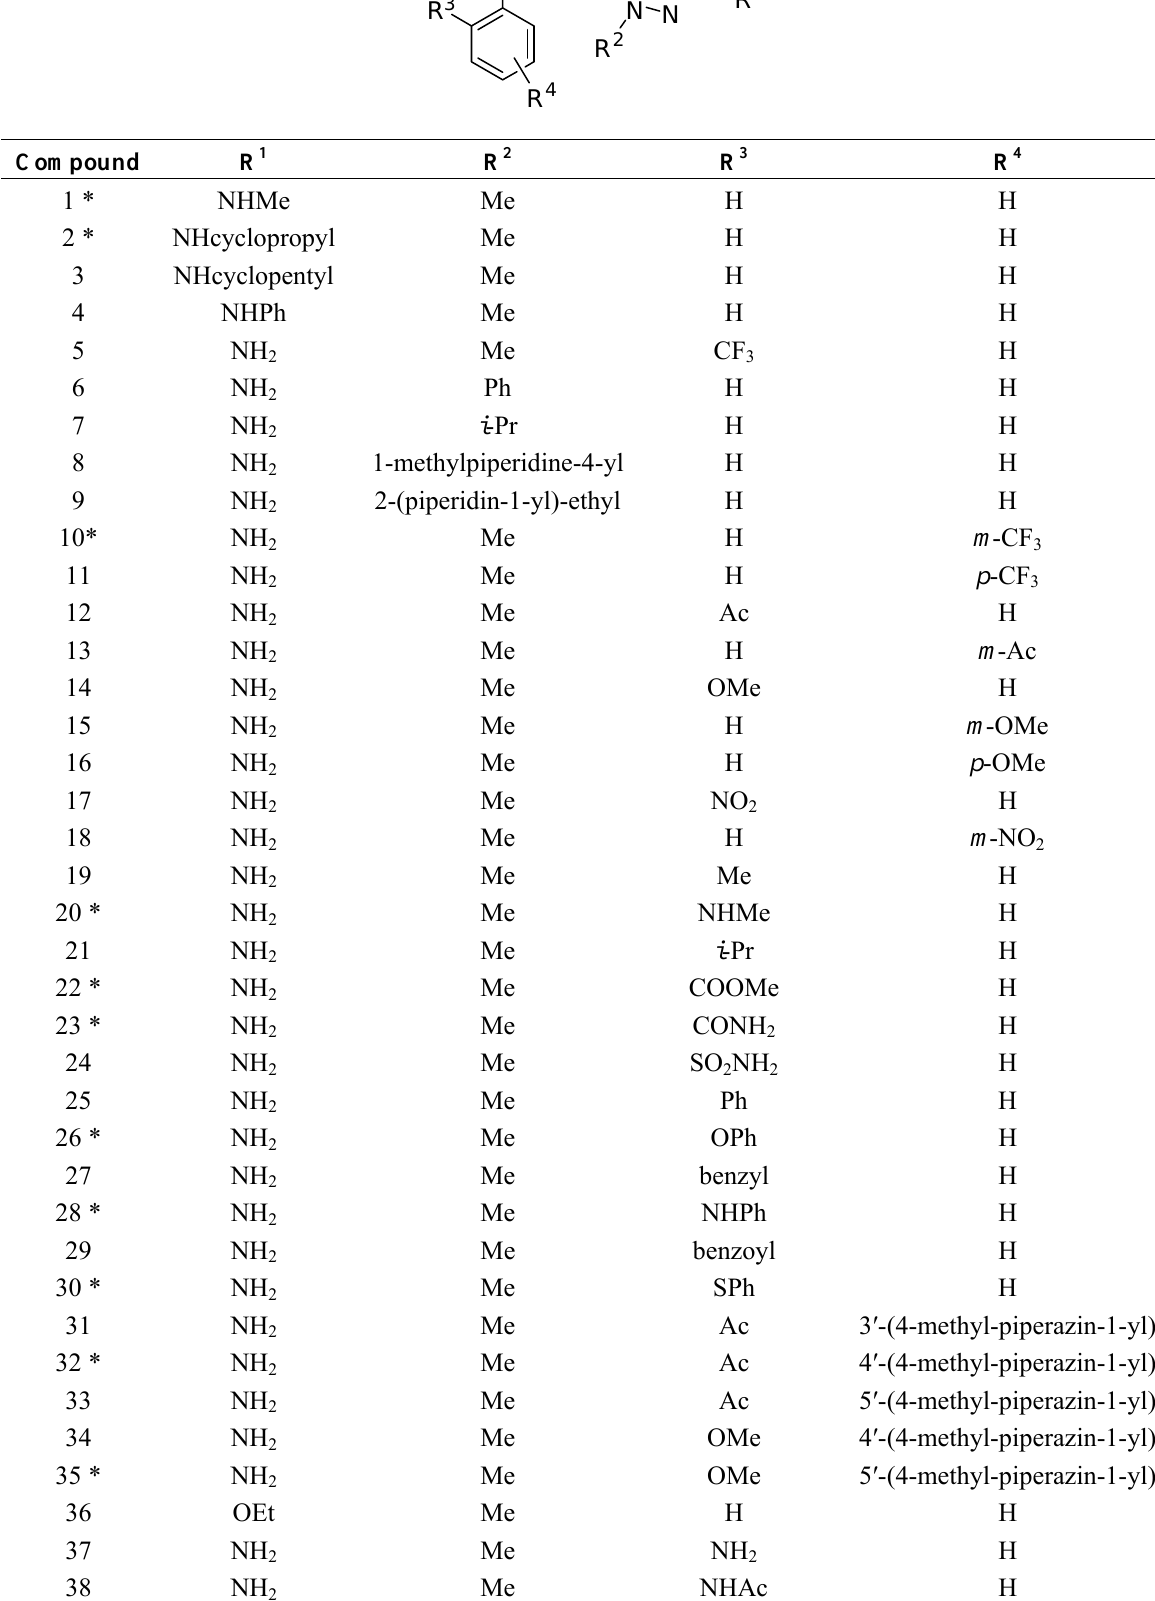
Table 1. Structures of 73